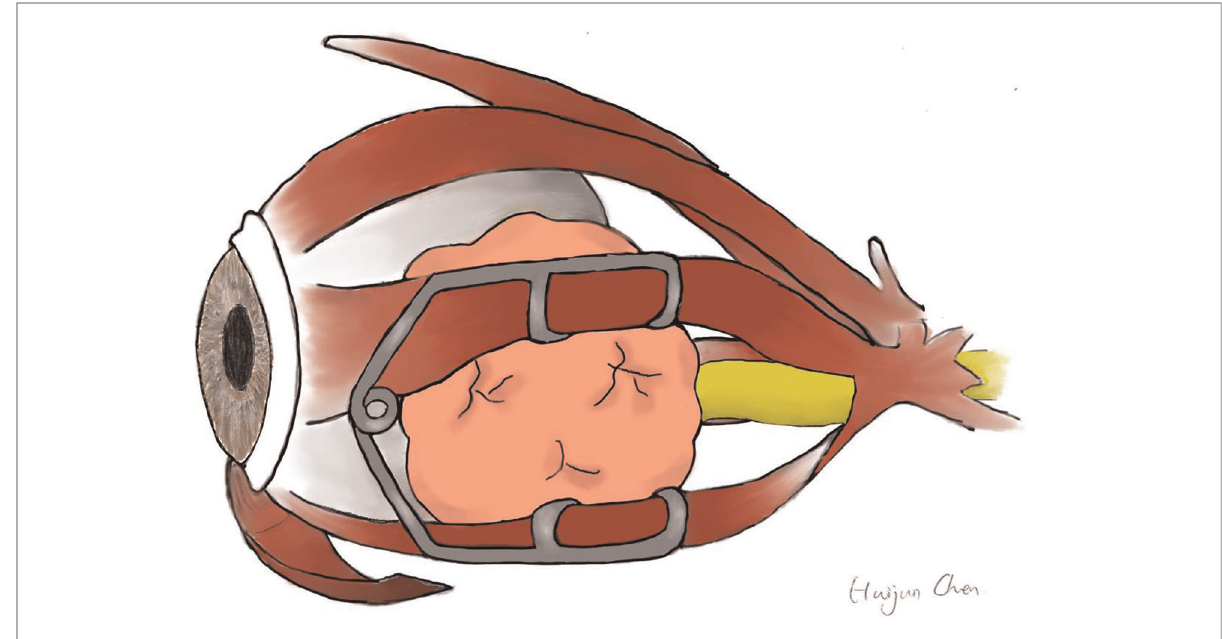
FIGURE 4 Schematic illustration of an eyelid speculum keeping the MRM and IRM